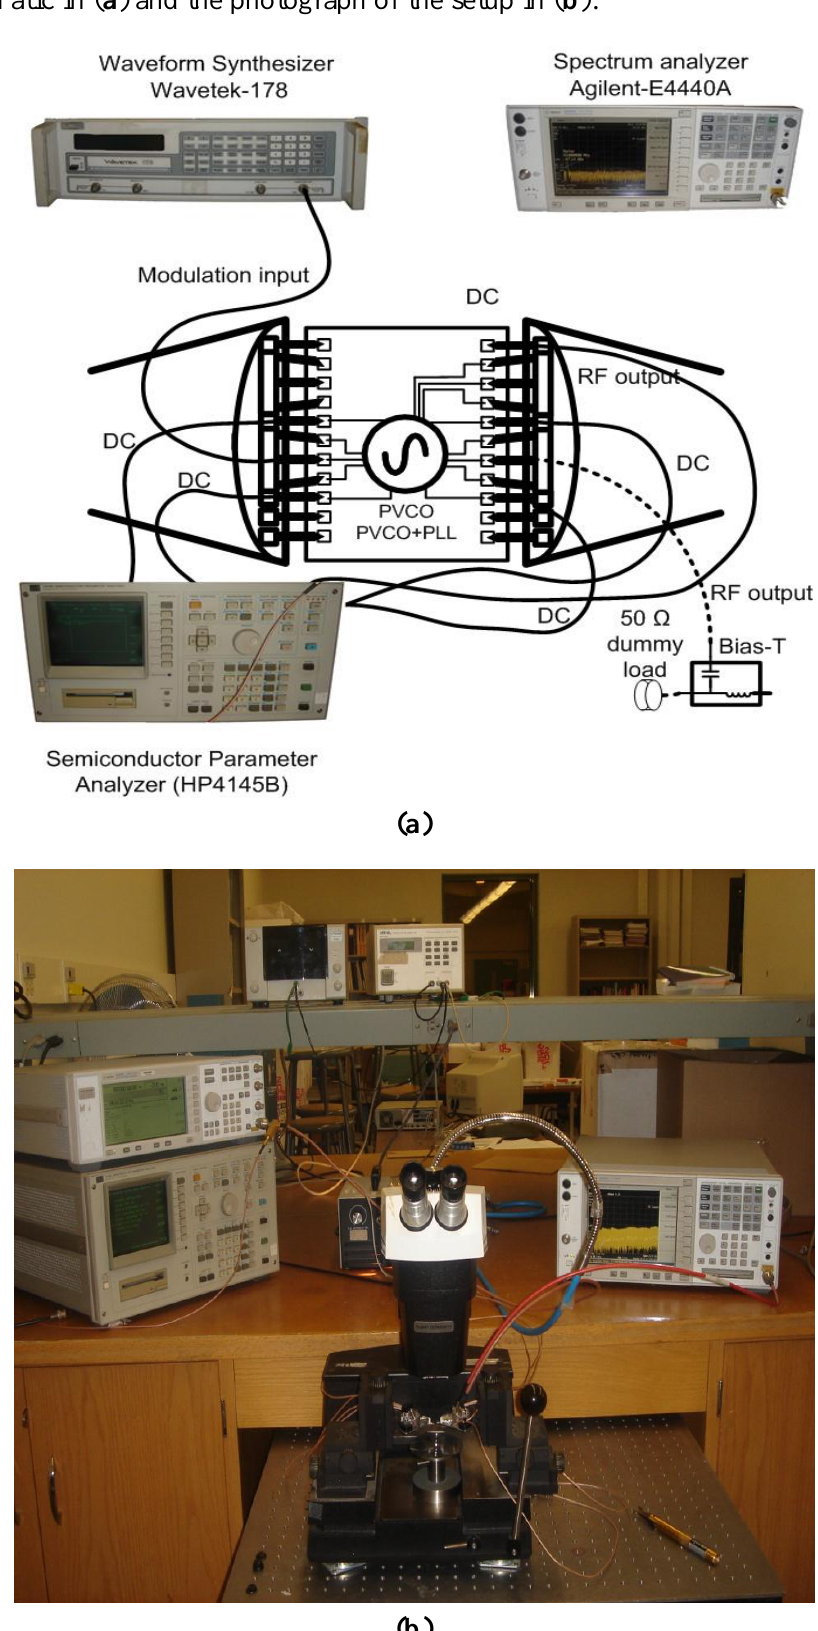
Figure 7. Experimental Setup used for the measurements of the transmitters showing the setup schematic in ( a ) and the photograph of the setup in ( b